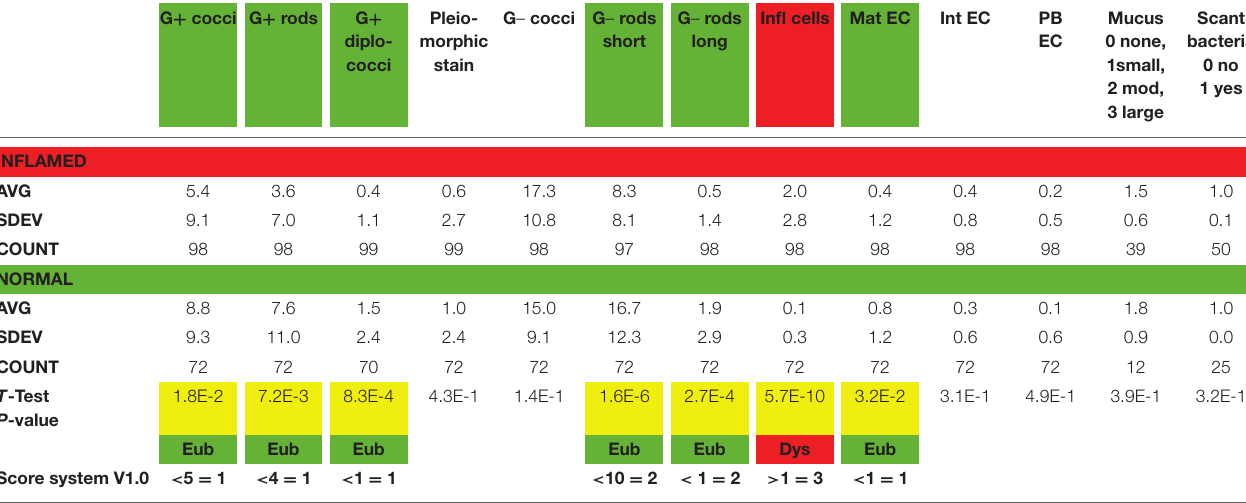
TABLE 2 | Subsample A average counts by morphotype or cell type to establish a preliminary scoring system. G + cocci G +